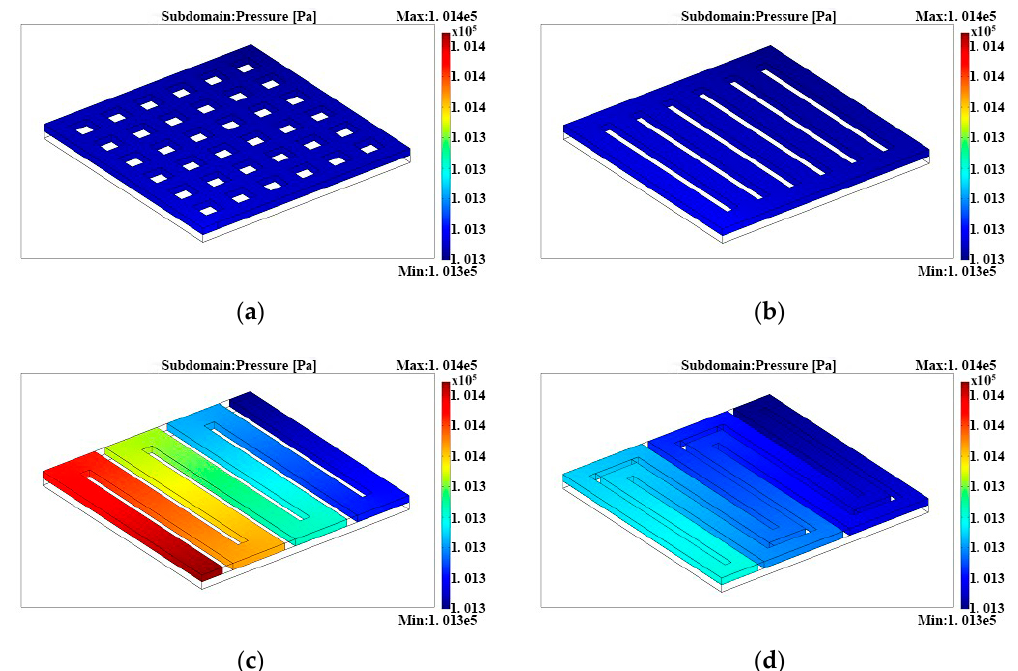
Figure 2. Pressure distributions in ( a ) grid flow fields, ( b ) parallel flow fields, ( c ) single-serpentine flow fields, and ( d ) double-serpentine flow fields.